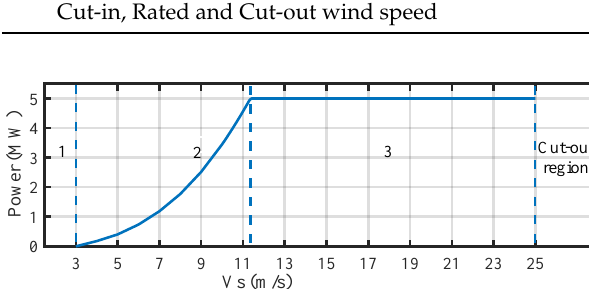
Figure 2. Power curve of a 5 MW wind turbine.